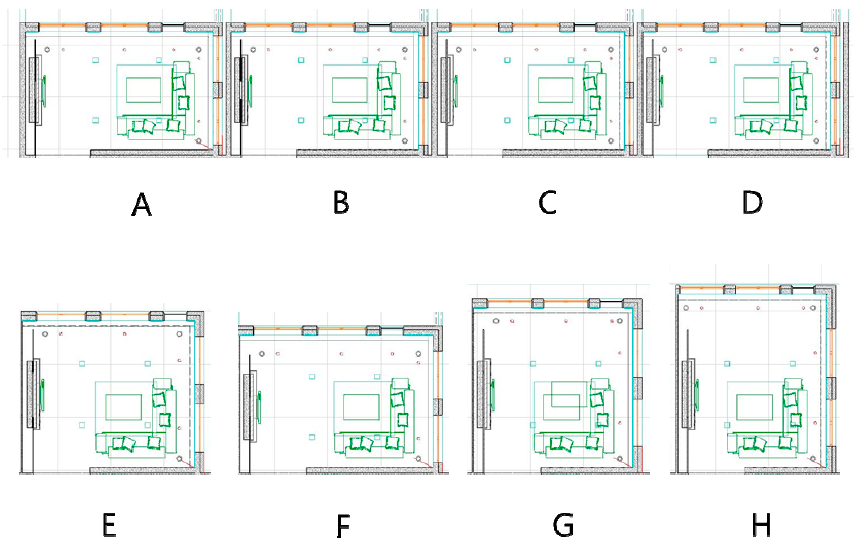
Figure 2. Layout of the spaces created virtually for the living room (Ceiling height varied for A – D , Base scenarios = A : 2.4 m; Room shape varied for E – F , Base scenarios = G : 6 m ˆ 6 m). Table 1. Living room dimensions. Table 1. Living room